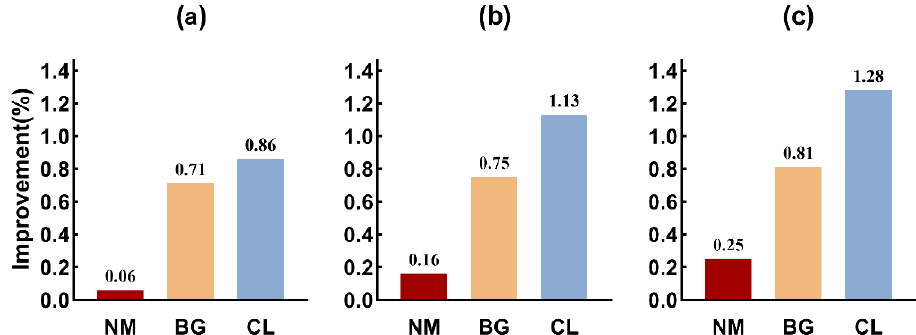
Figure 6. Performance comparison experiment between MFAM and RFAM. Results are improve- ment compared to baseline (GaitSlice*) of rank-1 accuracies without view variation, excluding the identical-view cases. ( a ) Accuracy improvement of introducing RFAM ( b ); Accuracy improvement of introducing MFAM; ( c ) Accuracy improvement of introducing MFAM and RFAM.